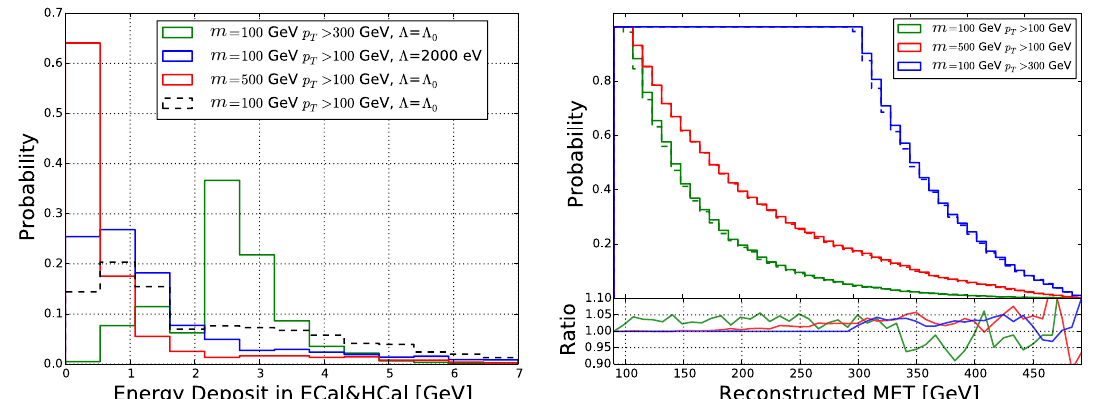
Fig. 5 Left: energy deposit of quirk pair in ECal and HCal within time of 25 ns. Right: the cumulative curve for the distributions of reconstructed MET. Note that the tails are dominated by the statistical fluctuation. The dashed lines have taken into account the quirk energy deposit